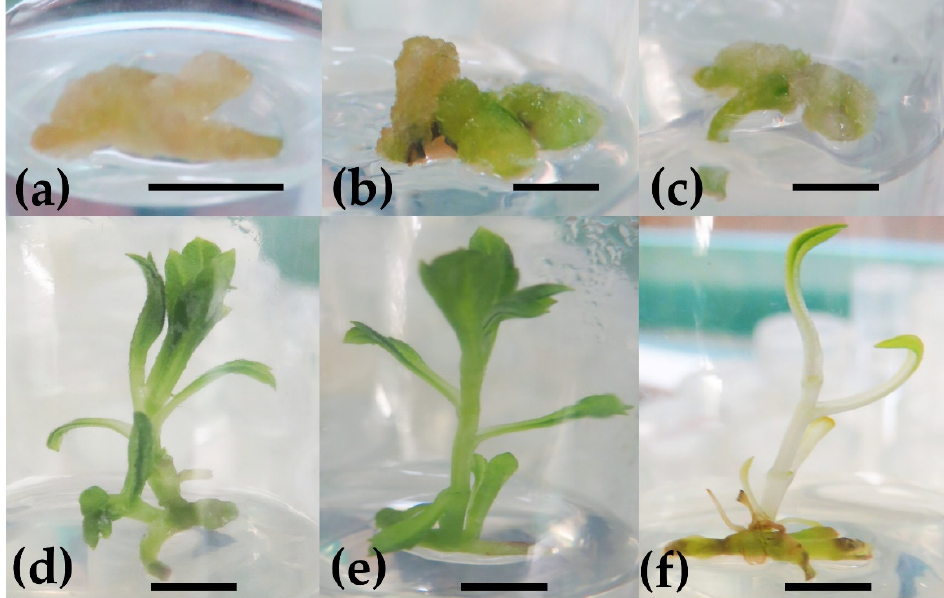
Figure 3. Morphogenetic responses of nodal explants after 15 days of their incubation: ( a ) BAP (0.1 mg/L) with PIC (1.0 mg/L), ( b ) KIN (0.1 mg/L) with 2,4-D (1.0 mg/L), ( c ) BAP (0.1 mg/L) with PIC (0.1 mg/L), ( d ) KIN (0.1 mg/L) with PIC (1.0 mg/L), ( e ) BAP (0.1 mg/L) with 2,4-D (0.1 mg/L), ( f ) BAP (0.1 mg/L with IAA (1.0 mg/L). Scale bar = 10 mm.